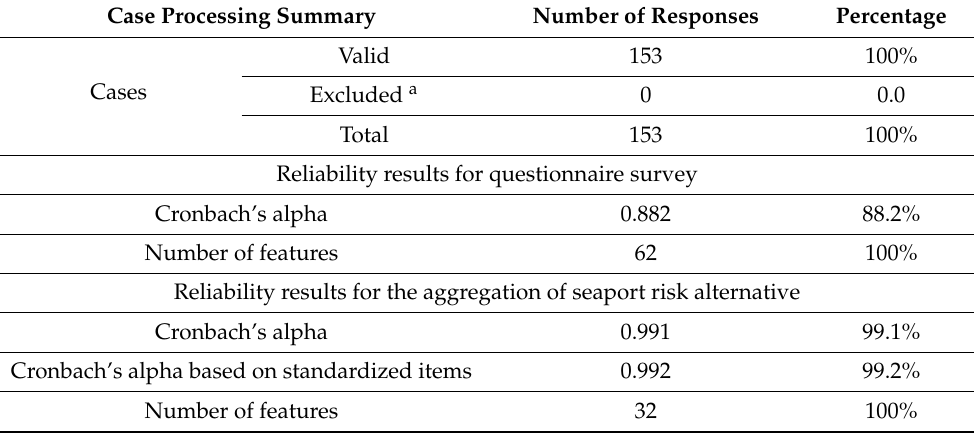
Table 4. Result of reliability